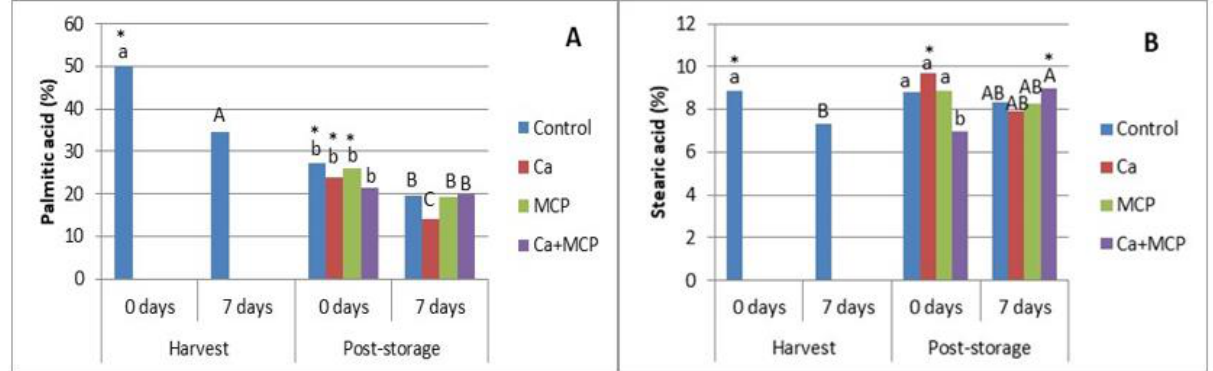
Figure 1. Changes in the saturated fatty acids, palmitic ( A ) and stearic ( B ), at harvest and after 6 months of storage at 0.5 ◦ C and their respective shelf-life (7 days at ≈ 22 ◦ C), in ‘Golden Delicious’ apples subjected to postharvest treatments with calcium chloride (Ca), 1-MCP (MCP), calcium chloride plus 1-MCP (Ca + MCP) and control. Lower-case letters compare treatments at harvest and after 6 months, and upper-case letters compare treatments after shelf-life. Columns with the same lower- or upper-case letter are not significantly different as determined by Duncan’s multiple range test at p < 0.05. * represents significant differences between harvest and shelf-life or between poststorage and shelf-life for each treatment, at p < 0.05.